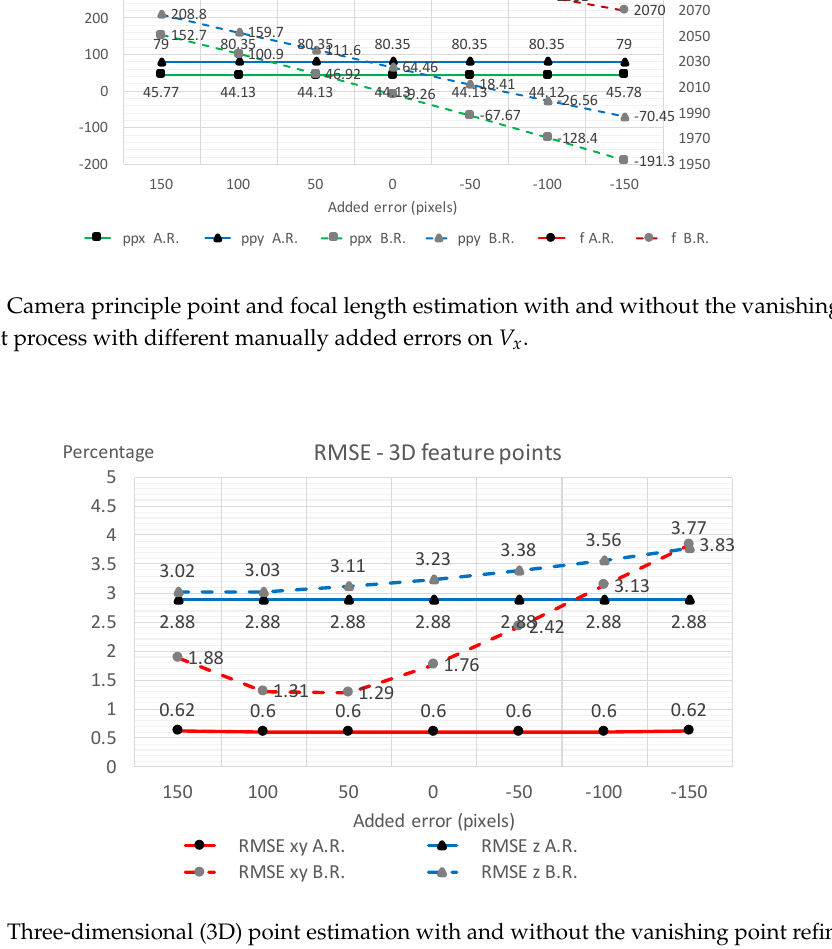
Figure 14. Three-dimensional (3D) point estimation with and without the vanishing point refinement process with different manually added errors on V x